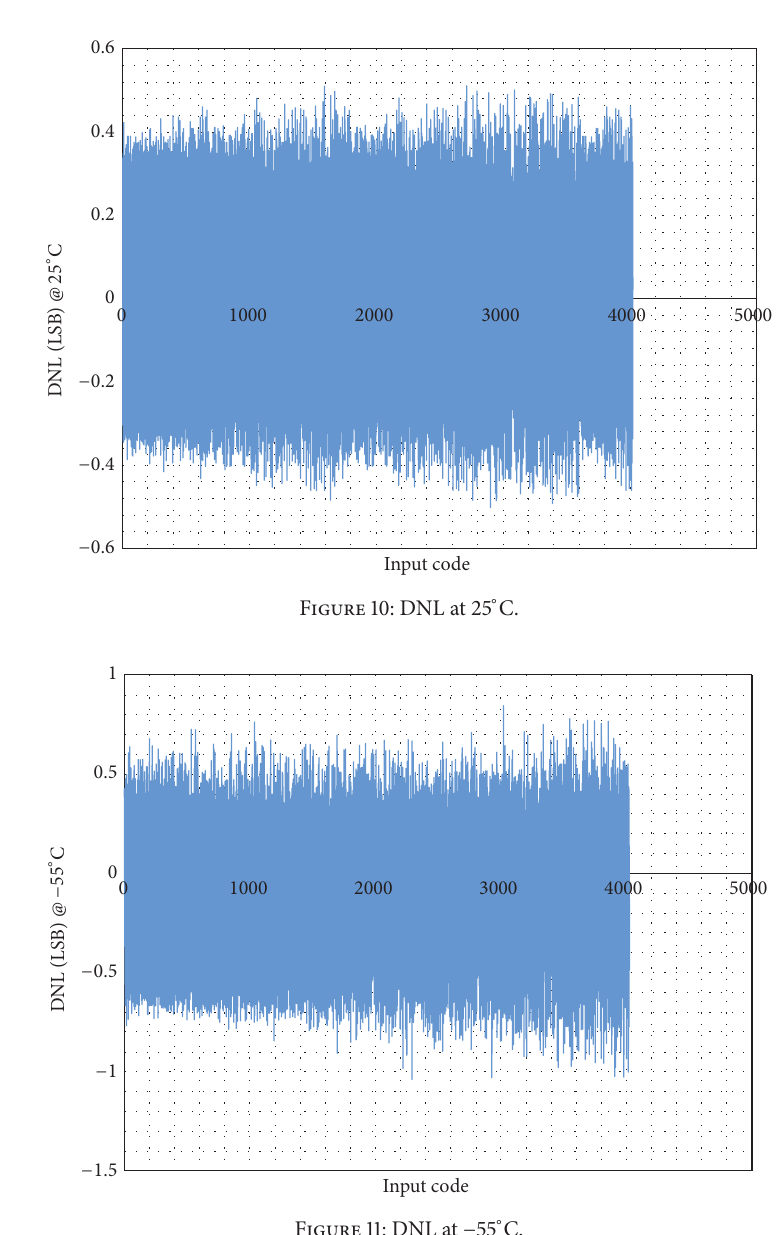
Figure 11: DNL at − 55 ∘